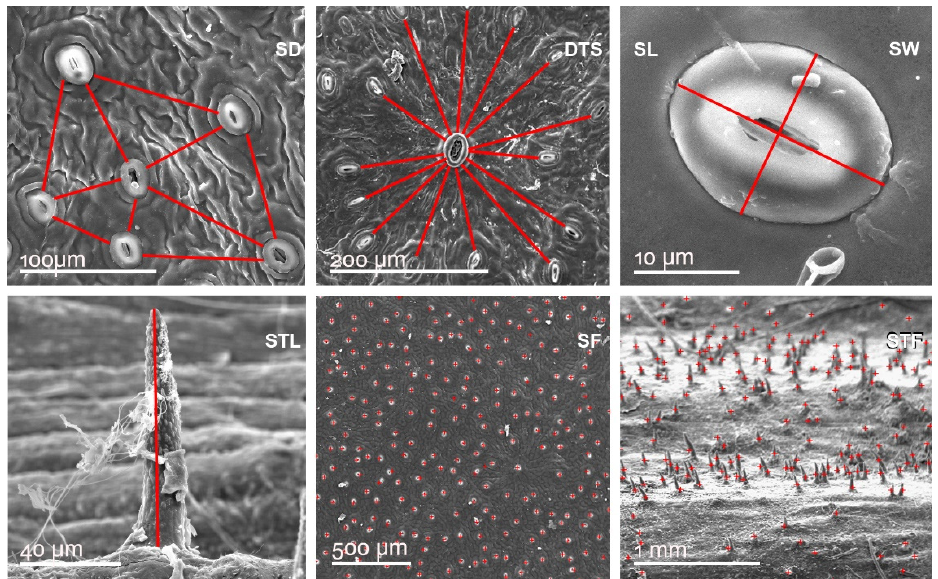
Figure 10. Leaf and stem specific morphological traits (MT) evaluated by morphometry. Leaf stomata distance—SD; Leaf D-type stomata distance—DTS; Leaf stomata length—SL; Leaf stomata width—SW; Stem trichome length—STL; Leaf stomata frequency on 1.5 mm 2 —SF and Stem trichome frequency 3 mm 2 each—STF.